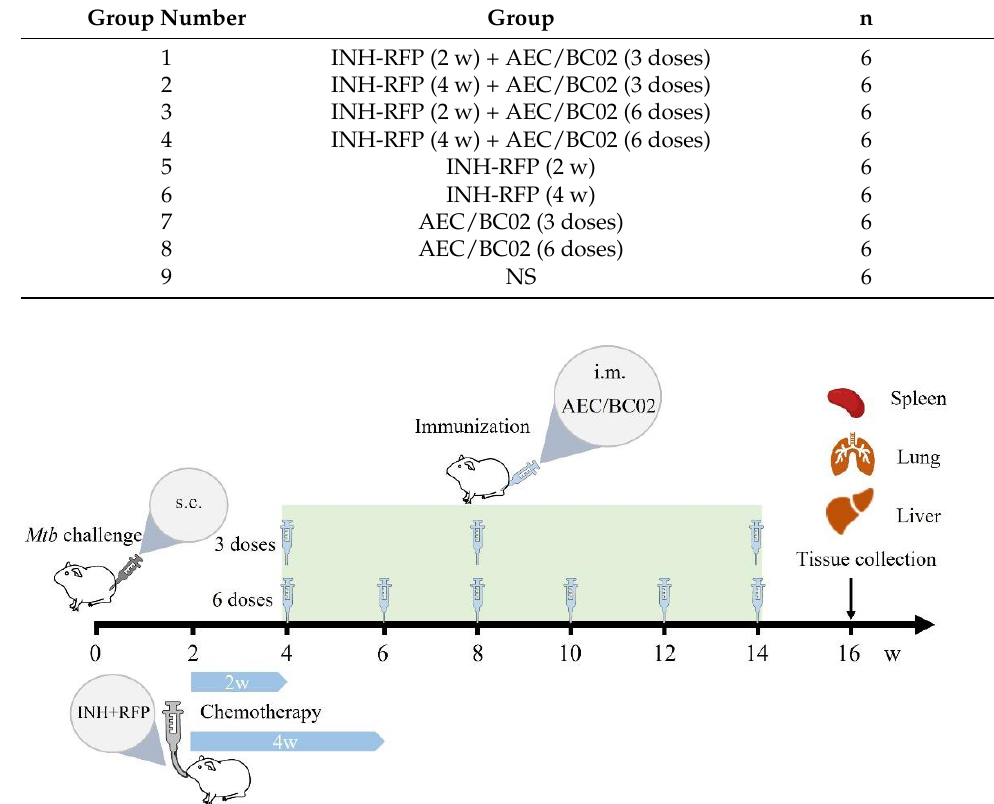
Table 1. Description of the experimental guinea pig groups.